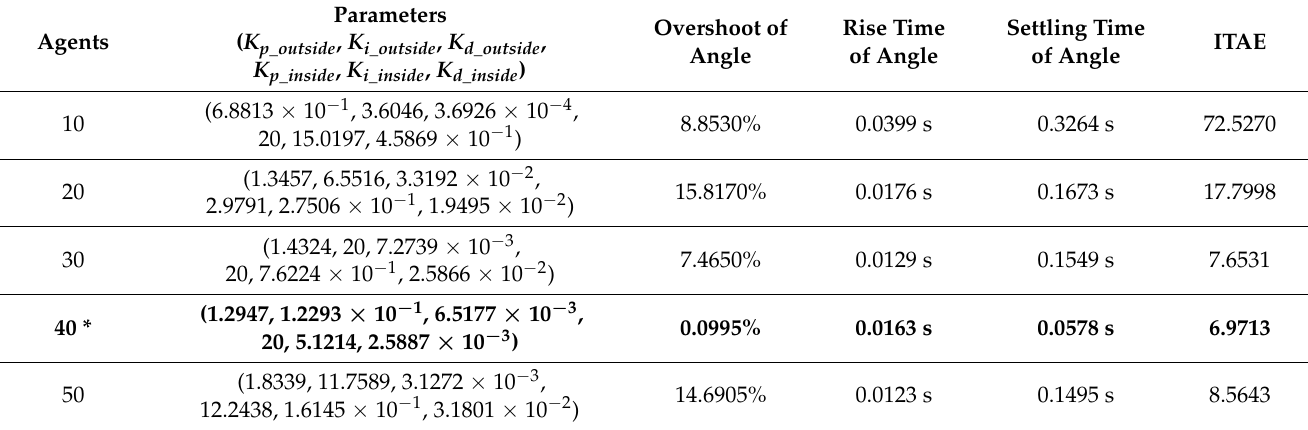
Table 5. Attitude control of balancing robots under WOA-PID algorithm.